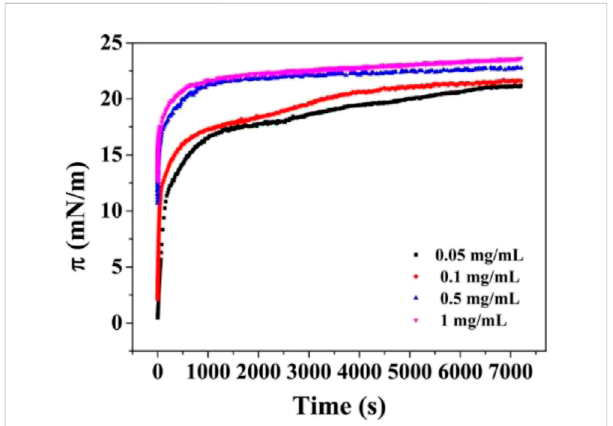
FIGURE 3 Adsorption kinetics, in terms of the time evolution of the surface pressure, for the adsorption of gliadin particles at the water/vapor function from dispersions of different concentrations. Reprinted from Peng et al. (2017), with permission from the American chemical society, copyright